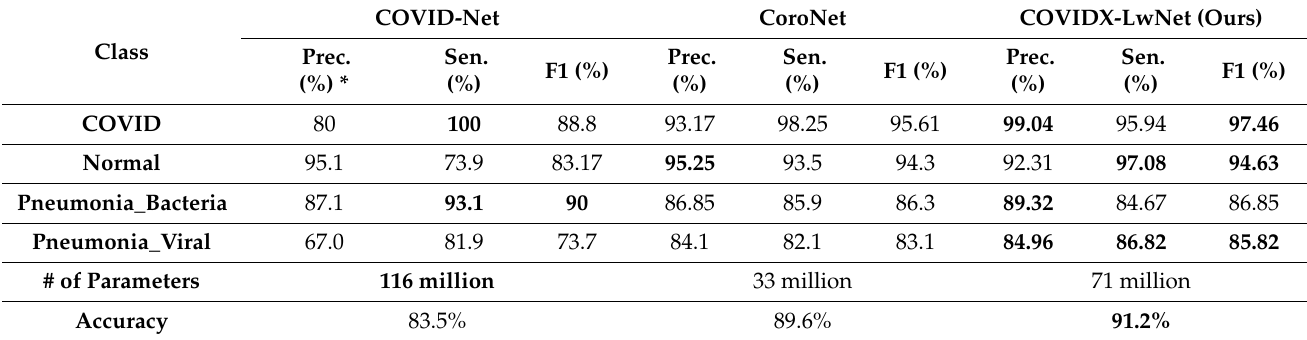
Table 7. COVID-Net, four-class performance comparison between CoroNet and COVIDX-LwNet.